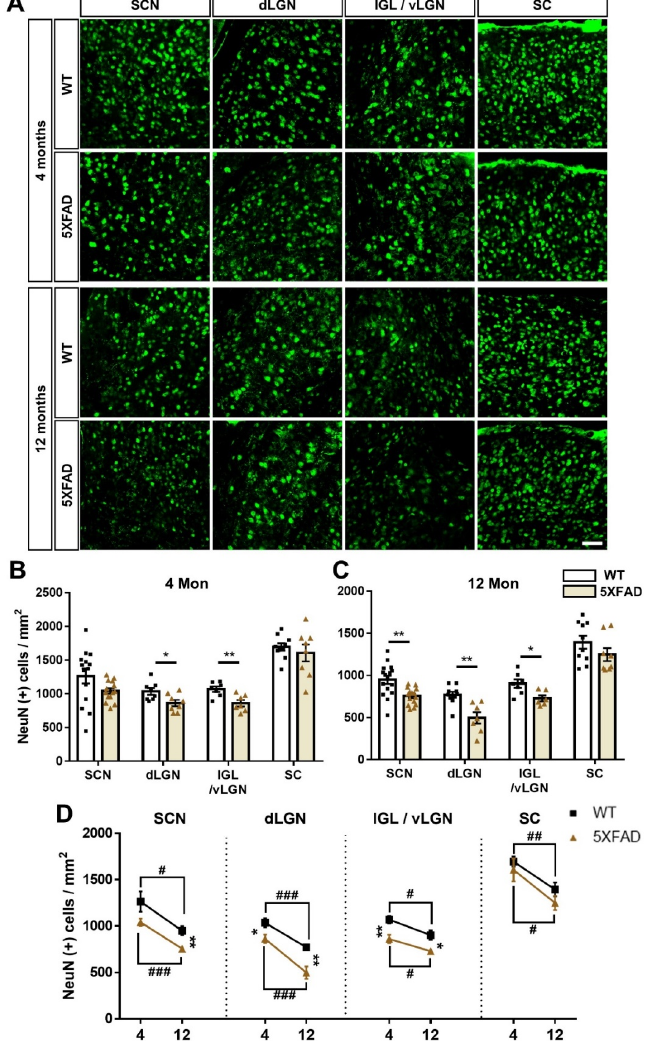
Figure 8. Neuronal loss in the retinorecipient area of the 5XFAD mice. ( A ) Representative images of neuronal nuclei (NeuN) in the SCN, dLGN, IGL, vLGN, and SC in the WT and 5XFAD mice. The scale bar is 50 μ m. ( B , C ) The quantitative graphs exhibit the NeuN (+) cells in the SCN, dLGN, IGL, vLGN, and SC of WT and 5XFAD mice (6 − 16 images of the brain sections were obtained from 5 mice in each group). Statistical analysis was conducted by a multiple t -test. ( D ) Comparison of the neuronal cell death by aging and AD progression. Statistical analysis was conducted by two-way ANOVA, followed by Tukey’s post hoc test. * p < 0.05, ** p < 0.01, # p < 0.05, ## p < 0.01, and ### p < 0.001 indicate a significant difference.